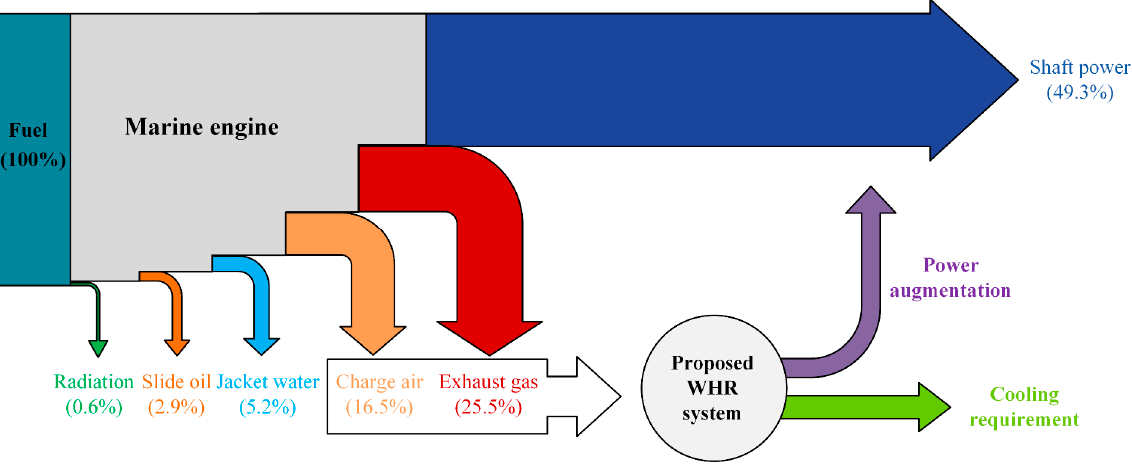
Figure 1. Heat balance diagram of the marine engine with the motivation and purpose of this work.